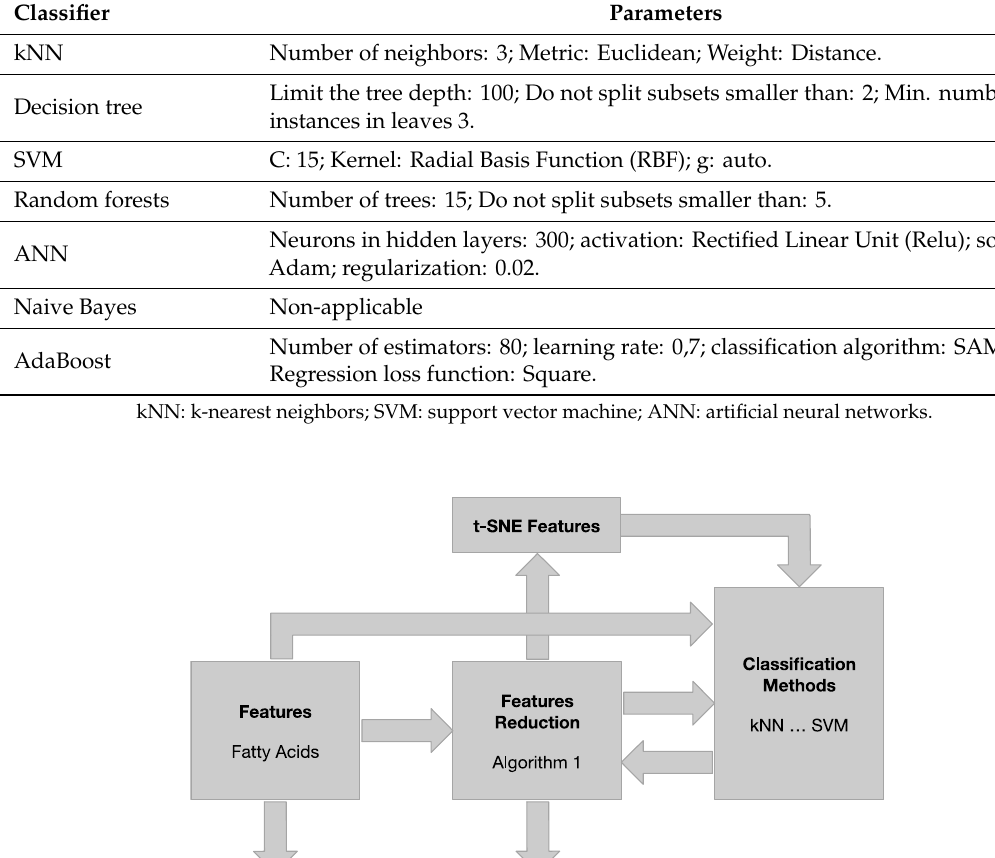
Table 1. Details of the parametrization used to tune each of the final classification models.